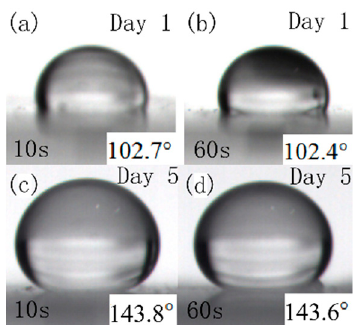
Figure 16. ICA in-situ measurements of diiodomethane at initial period for PU-Si17 sample immersed in seawater.